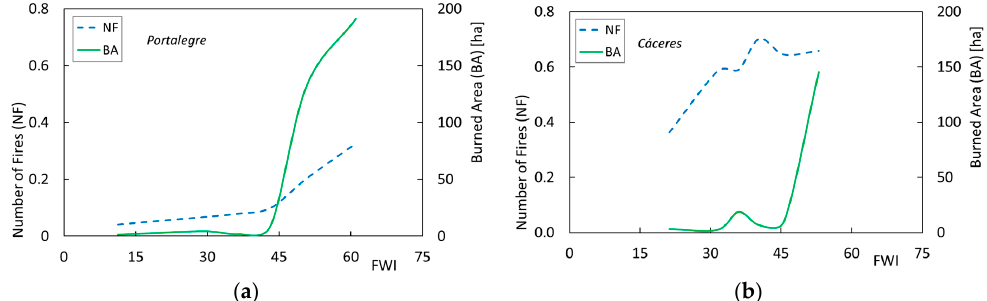
Figure A8. Average number of daily fires (NF) and burned area (BA) as a function of FWI for: ( a ) the Portuguese District of Portalegre and ( b ) the Spanish Province of Cáceres.